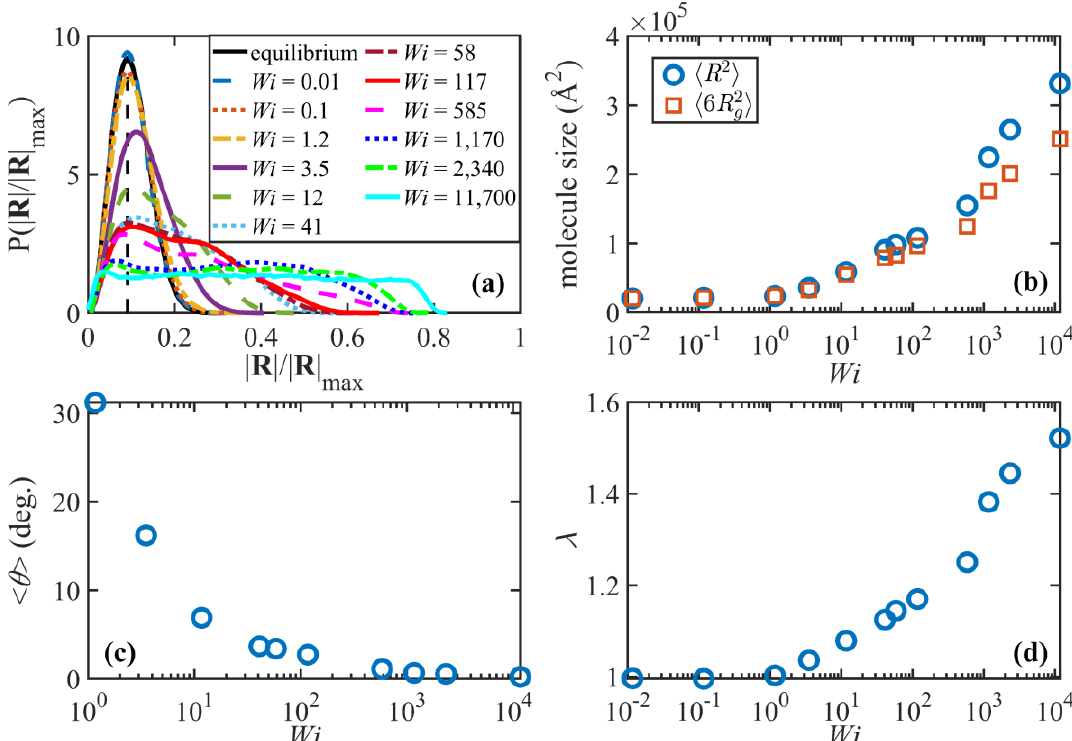
Figure 3. Probability distribution of the normalized magnitude of the end-to-end vector | R | / | R | max at various values of 𝑊𝑖 ( a ), the mean-square of the end-to-end vector and 6 times the radius of gyration vs. 𝑊𝑖 ( b ), ensemble average chain orientation angle with respect to the flow direction vs 𝑊𝑖 ( c ), and tube stretch vs 𝑊𝑖 ( d ).